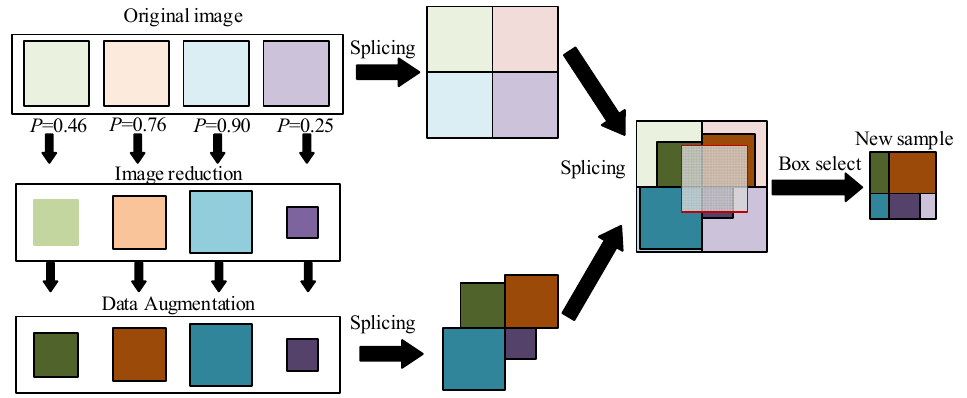
Figure 7. Small target data augmentation.